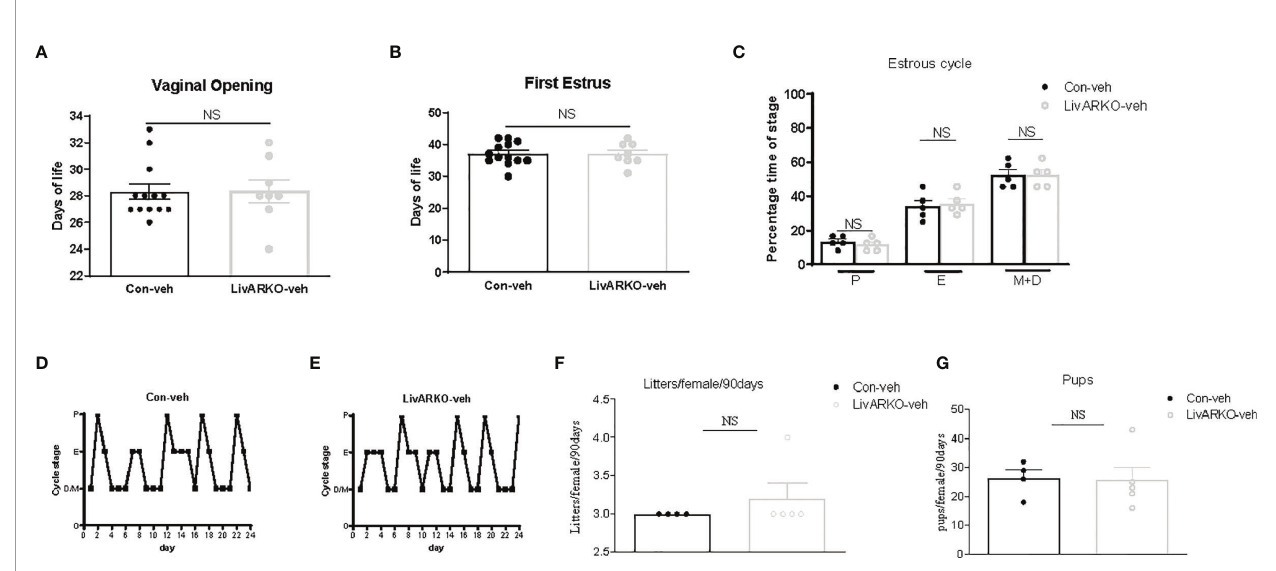
FIGURE 2 | Female puberty, cyclicity and fertility. LivARKO mice exhibited similar age of puberty onset, assessed by examination of vaginal opening (A) and fi rst estrus (B) , as control mice. (C) . Percentage of time spent in each of the stages (4-month old) was not signi fi cantly different between control and LivARKO mice. Representative data for vaginal cytology from individual Con (D) , and LivARKO mice (E) . There were no signi fi cant differences between LivARKO and controls in either total numbers of litters per female (F) , or numbers of pups per female (G) . Data were compared by two-tailed student ’ s t-tests. Values are mean ± SEM, n = 5-13/group. NS, non-signi fi cant; P, proestrus; E, estrus; M, metestrus; D,